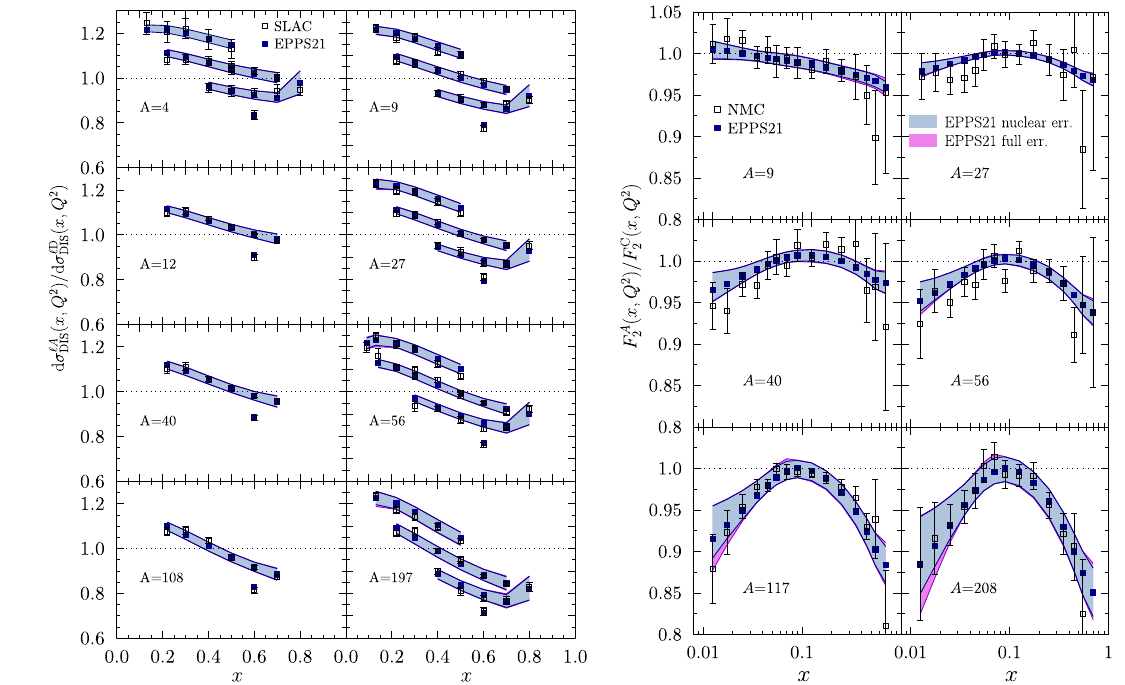
Fig. 21 Left: The SLAC data [43] for DIS cross-section ratios com- pared with the EPPS21 analysis. To increase the visibility, the data and theory values have been multiplied by 1.2, 1.1, 1.0, 0.9 for Q 2 =